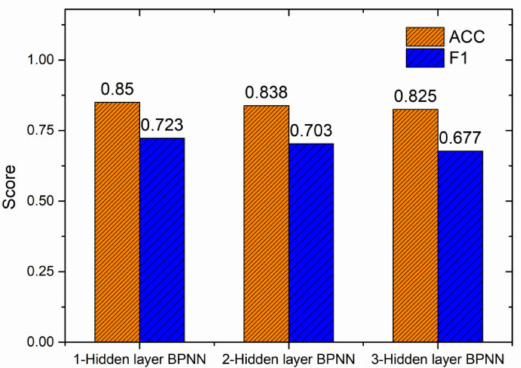
Figure 9. Classification performance of 1-Hidden layer BPNN, 2-Hidden layer BPNN, and 3-Hidden layer BPNN.